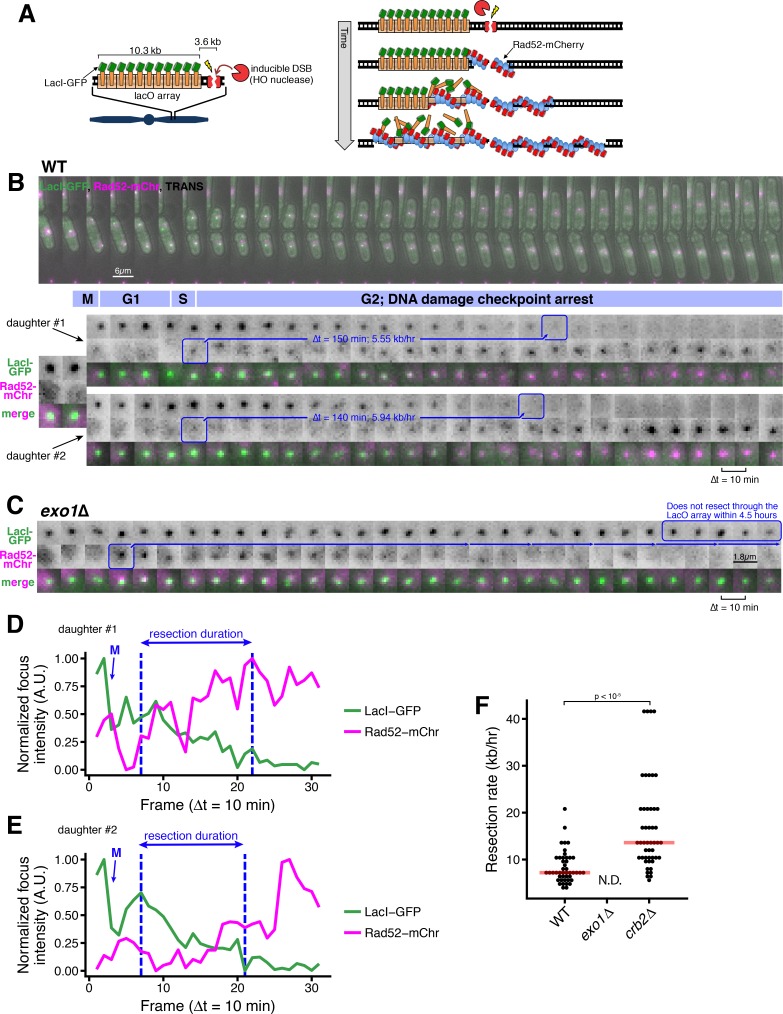
A microscopy-based assay to measure long-range resection in single cells.(A) Design of the LacO resection assay in S. pombe. HO endonuclease cut cite (HOcs) and LacO integration at the Mmf1 locus on Chr II allows live-cell measurements of resection rates. Rad52-mCherry loads on DSB ends after resection initiation, and LacI-GFP is displaced as resection creates long tracts of ssDNA through the LacO array. (B) DSB resection events in two WT daughter cells. The majority of the S. pombe cell cycle is spent in G2, and all DSBs are observed in S/G2 based on the timing of mitosis and cell fission. Images shown are maximum intensity Z-projections acquired at 10-min time intervals. Blue annotations denote the starting point of resection (first frame with a detectable Rad52 focus, shortly after resection begins) and the end point (first frame with total loss of the LacO/LacI-GFP focus) of individual resection events. These start/end frames mark the total duration of resection through the 13.87 kb distance between the HOcs and the distal end of the repetitive LacO array and are used to compute resection rate (kb/hr) for individual cells. (C) Representative resection-deficient exo1∆ cell that that loads on-target Rad52-mCherry but does not lose the LacO/LacI-GFP focus. Because resection of the LacO array is too slow to be completed during the window of data acquisition, we are not able to quantify the rate of resection in exo1∆ cells. (D and E) Quantification of LacO/LacI-GFP focus and Rad52-mCherry focus intensities over time for the cells shown in (B). The arrow and ‘M’ show the time of mitotic division, which leads to a decrease in GFP intensity. Quantification used full Z-stack images (not maximum intensity projections shown in B) at subpixel resolution with background normalization. See Materials and methods for more details. (F) Single-cell measurements of resection rate using the LacO resection assay. Horizontal red bars mark the median resection rate for each genotype. exo1∆ rates cannot be determined (N.D.) because resection through the LacO array does not complete within 5 hr of data acquisition. p-values shown are from pairwise two-tailed t-tests, using a Bonferroni correction for multiple comparisons. Number of biological replicates and counts of analyzed cells can be found in Supplementary file 2.